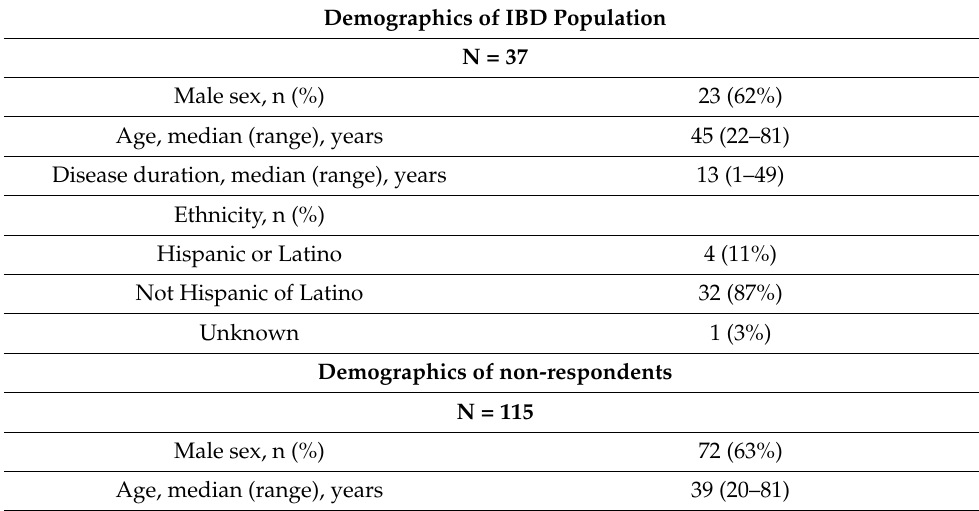
Table 1. Demographics of the included patients vs. the non-respondents.